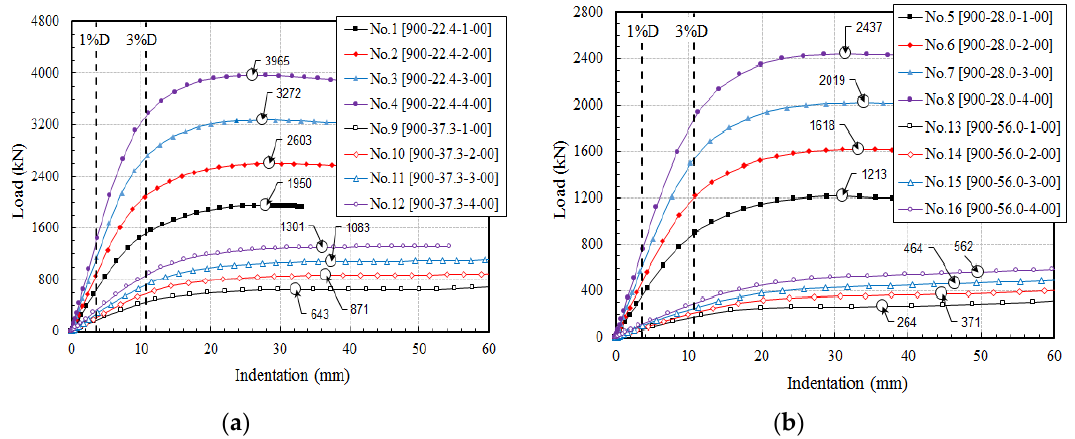
Figure 11. Load–indentation curves of S900 ( F y = 900 MPa): ( a ) 2 γ of 22.4 and 37.3; ( b ) 2 γ of 28.0 and 56.0.